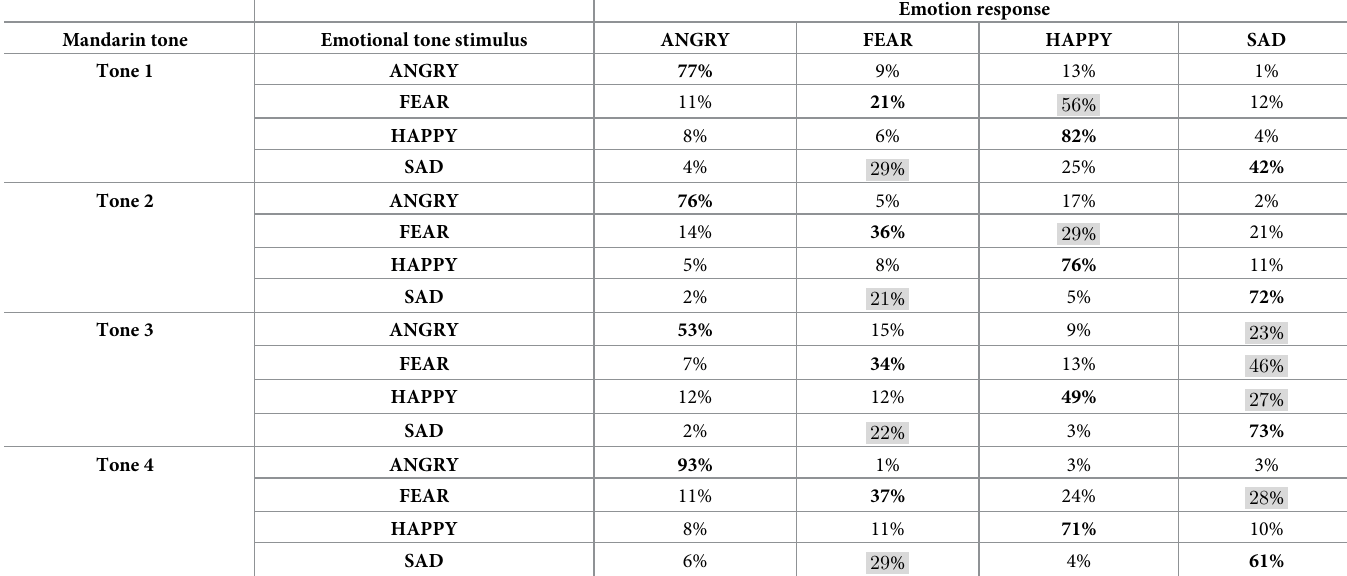
Table 7. Confusion matrices of emotion recognition responses for syllables presented in isolation. The most common error that exceeds 20% for each emotion is highlighted in gray.